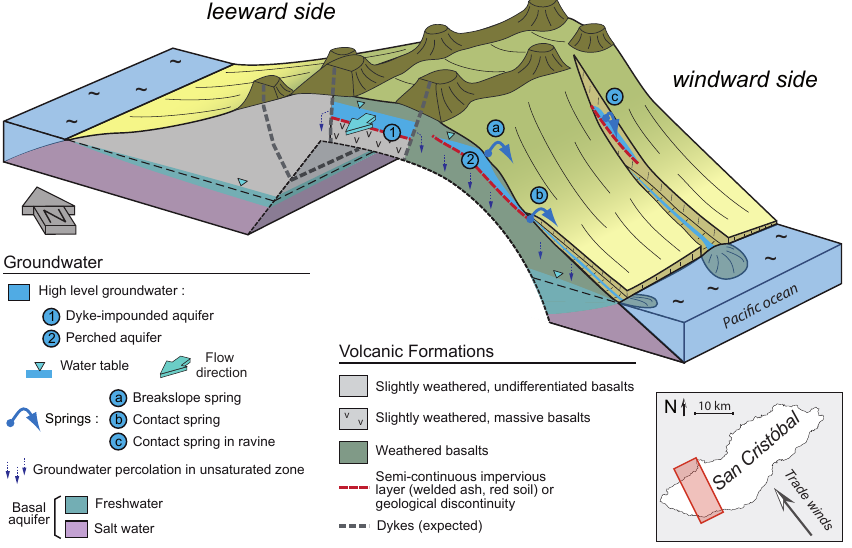
Fig. 7. Hydrogeological conceptual model of San Crist´obal Island, inferred from geomorphological observations and airborne electromag- netic survey. The configuration is asymmetric, the basal aquifer is thin and basalt are weakly weathered in the northern leeward side, while the basal aquifer is thicker and basalts are weathered in the southern, windward side. Springs are fed by perched aquifers and a dyke-impounded aquifer may be present in the central